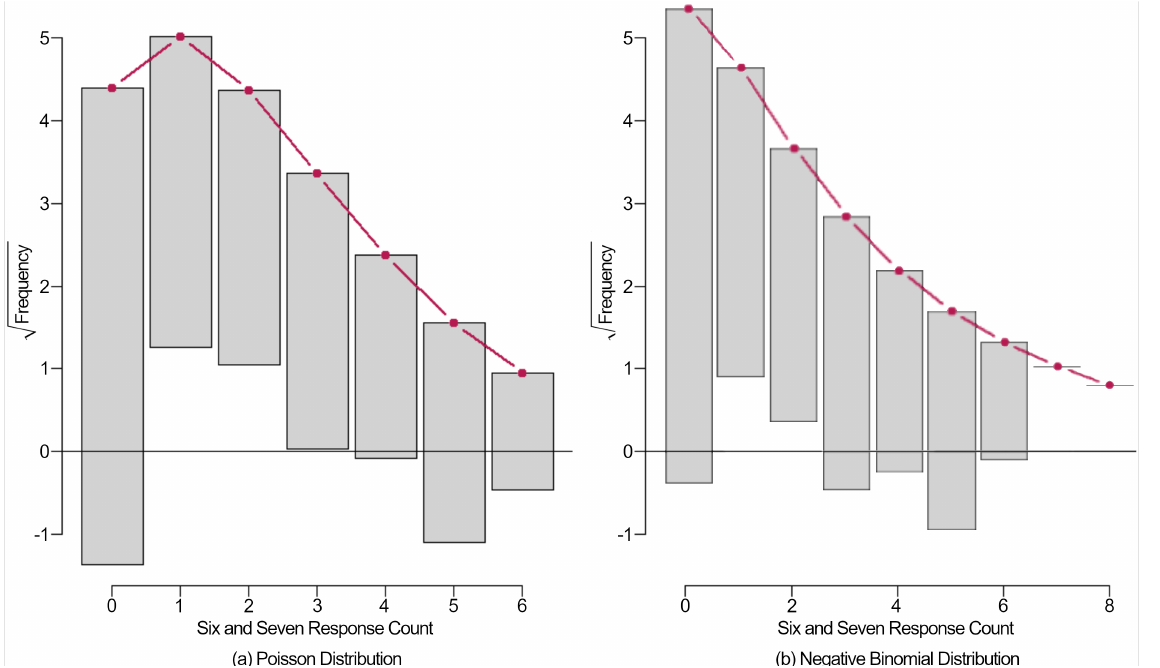
Figure 4. Rootogram functions showing the over and under dispersions of the “six and seven answer” counts from the SUS questionnaires. ( a ) shows the fit to a Poisson distribution; ( b ) shows the fit to a negative binomial